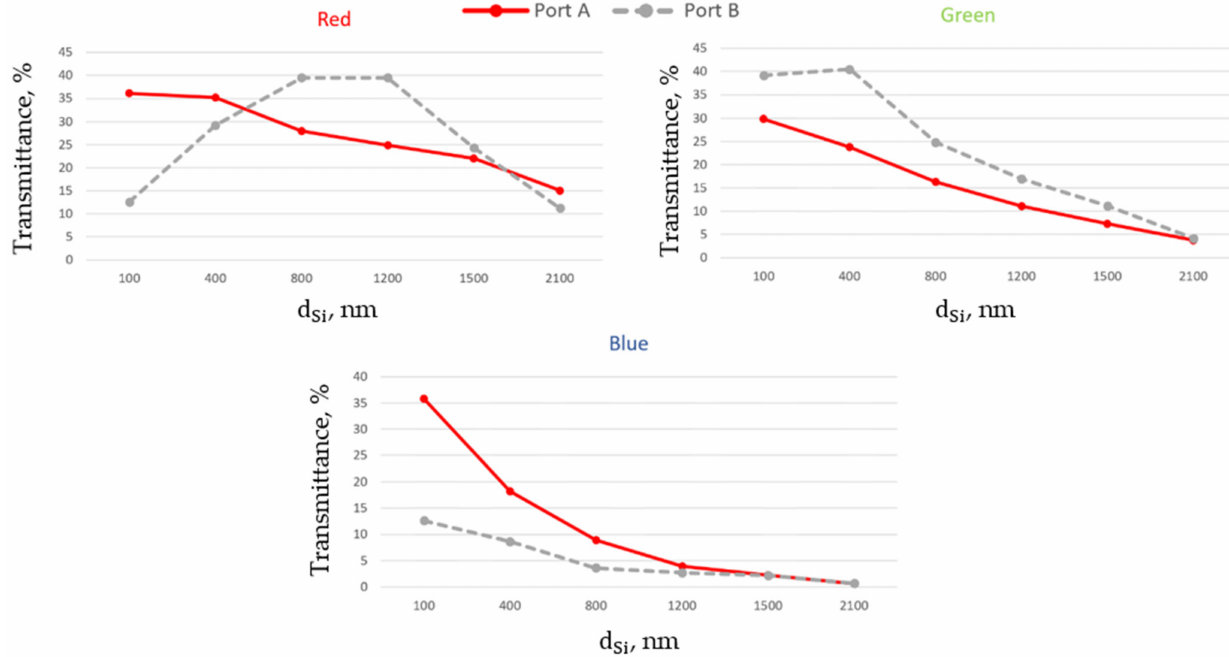
Figure 6. Total transmittance measured for three different RGB colors as a function of the distance between the deep-trenches at normal incidence and d ARC = 200 nm, d DT = 100 nm, W ∗ = 440 nm for inclined incidence α = 15 ◦ .